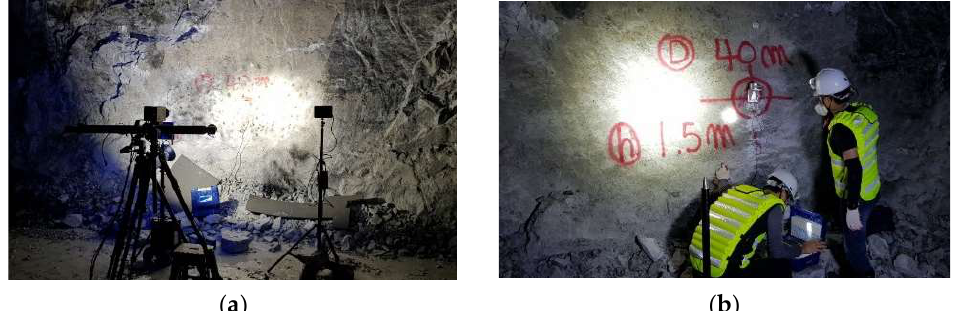
Figure 3. Photos of blasting face and measurement point: ( a ) DIC and high-speed camera equipment configuration; ( b ) installation of contact vibration meter.